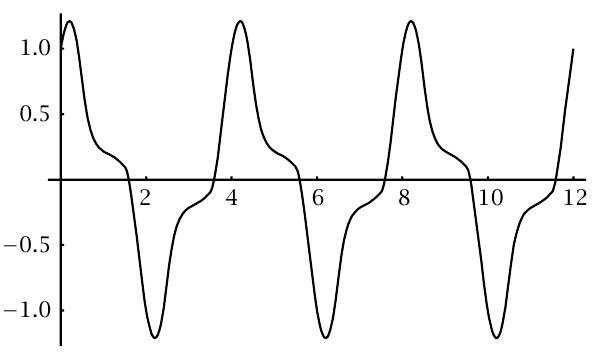
Figure 6.5 . T j (t) for b(t) = b cos (πt) , b = 3, d j = 3 .